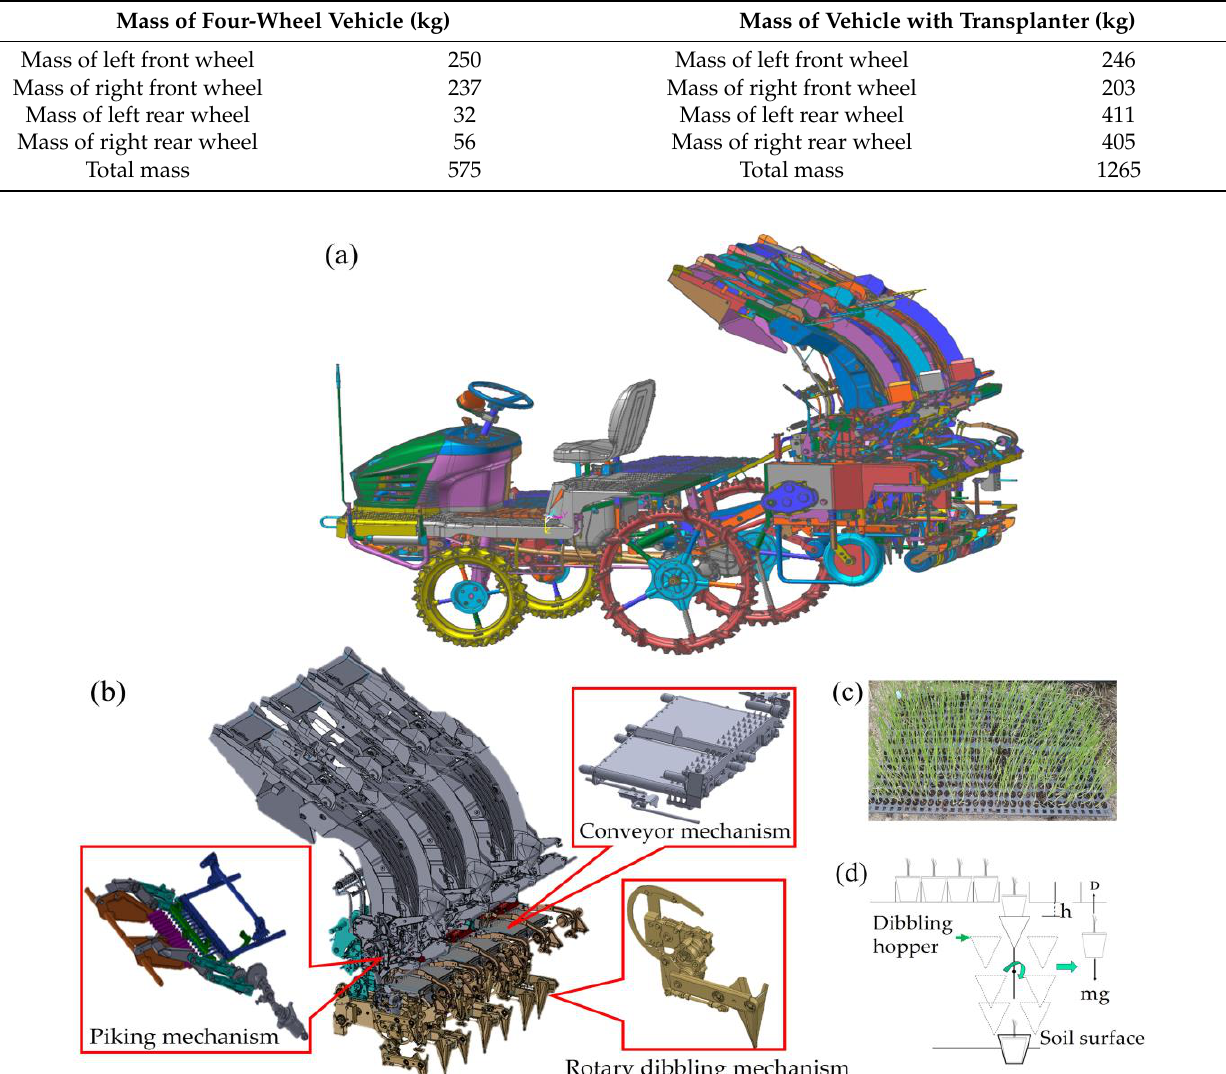
Figure 1. A 3-D model of the ( a ) 12-kilowatt self-propelled riding-type automatic onion transplanter, and ( b ) major components of the transplanting part, ( c ) onion seedling tray, and ( d ) transplanting mechanism. Table 1. Specification of the 12-kilowatt self-propelled riding-type automatic onion transplanter un- der development.